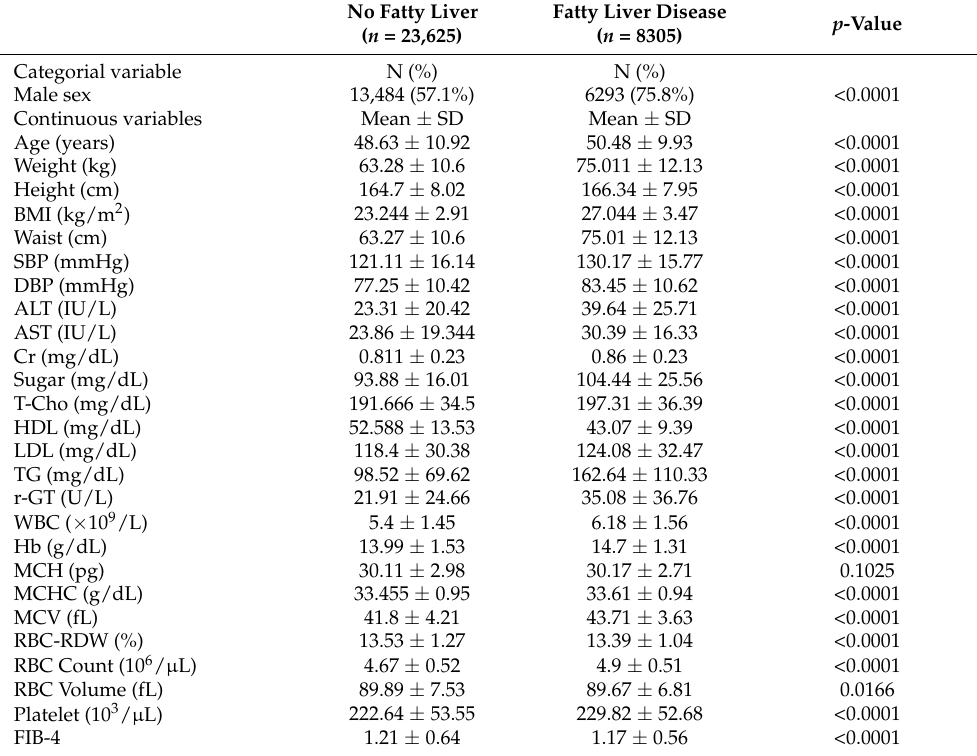
Table 1. Comparison of the fatty and nonfatty